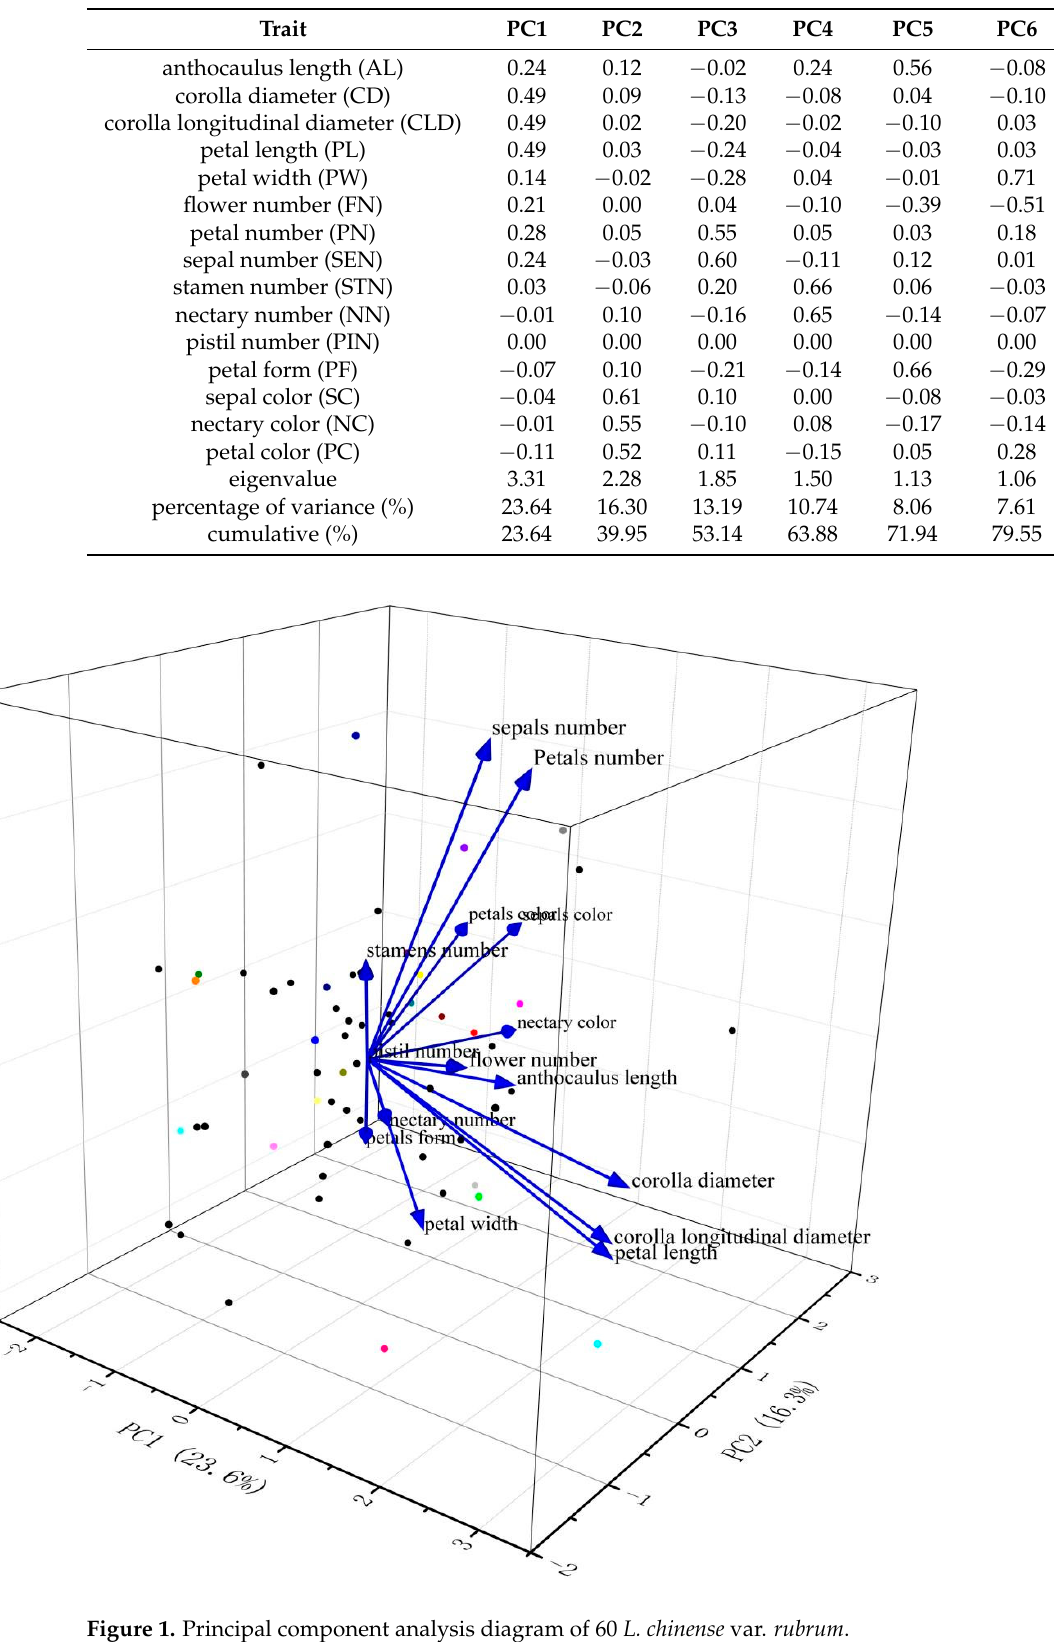
Figure 1. Principal component analysis diagram of 60 L. chinense var. rubrum .